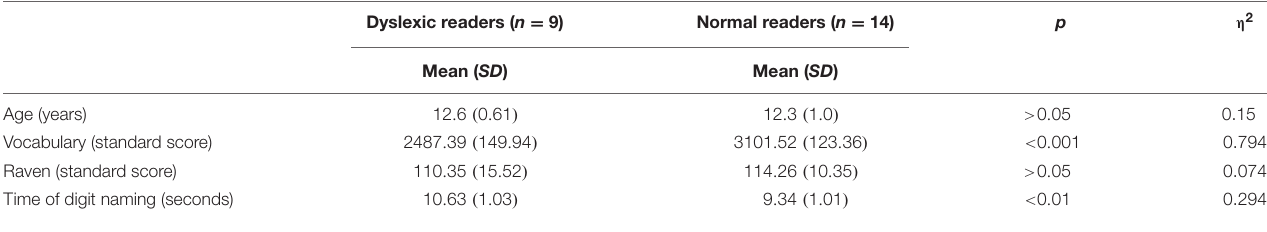
TABLE 1 | Information concerning the dyslexia and control